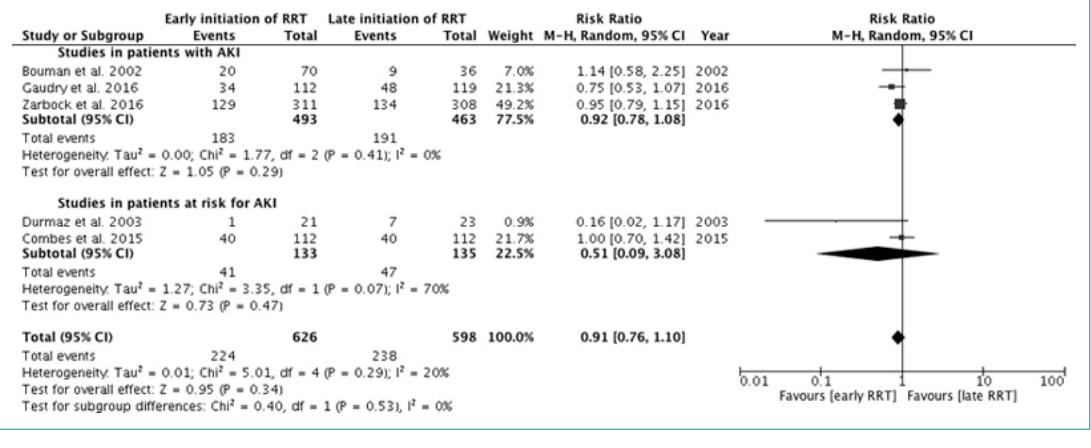
Figure S2: 28-day mortality. Forest plot demonstrating the impact of early or preventive renal replacement therapy on 28-day mortality com- pared with late renal replacement therapy. Data are presented as risk ratios with 95% confidence intervals. A random-effects model was used.